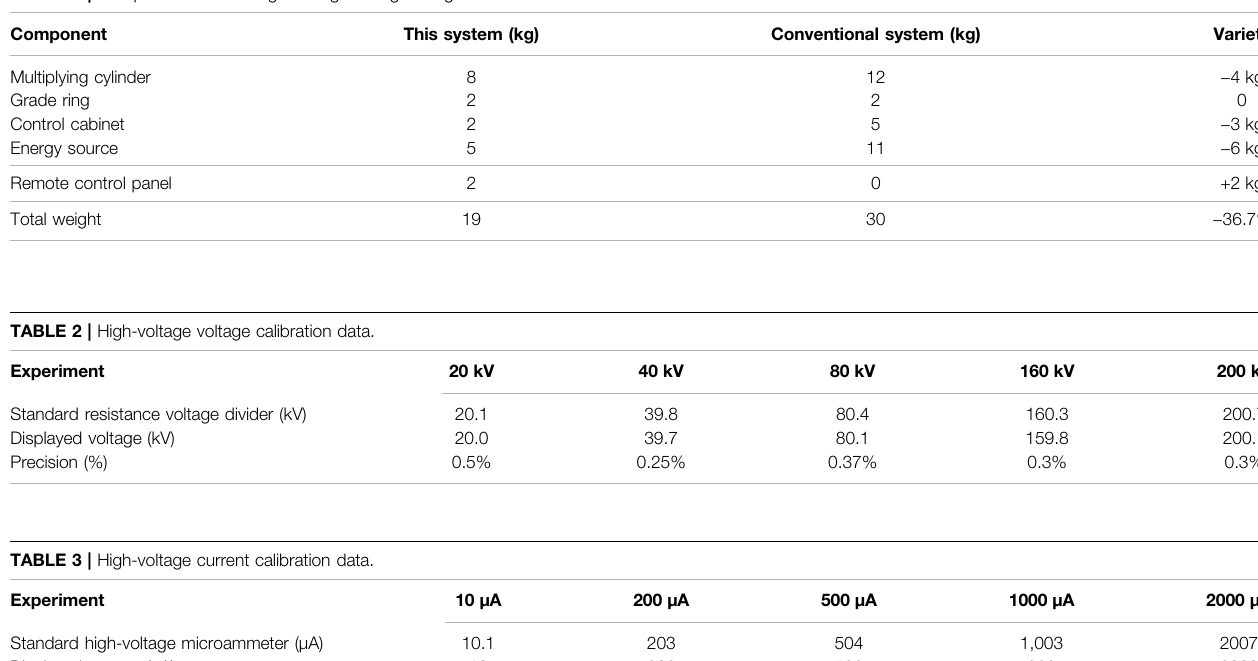
TABLE 1 | Comparison of the weight of high-voltage DC generator.